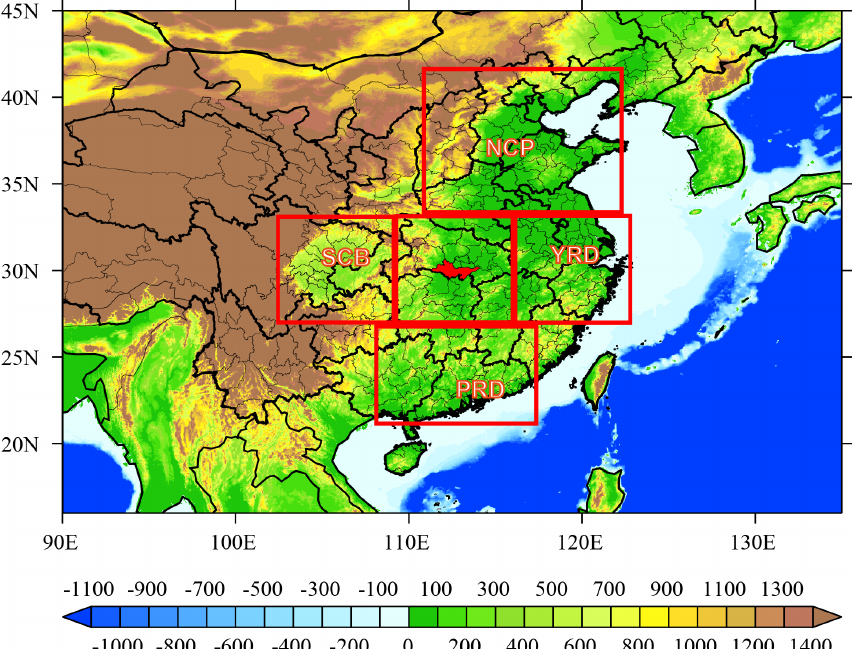
Figure 1. The location of Jingzhou (red area) and the major haze pollution regions of the NCP, YRD, PRD, and SCB. The areas framed in red are used to investigate the inter-regional impacts using GEOS-Chem sensitivity simulations. The overlaid map shows the surface elevation (m) from 2min gridded global relief data (ETOPO2v2) available from the NGDC Marine Trackline Geophysical database (http: //www.ngdc.noaa.gov/mgg/global/etopo2.html, last access: 27 February